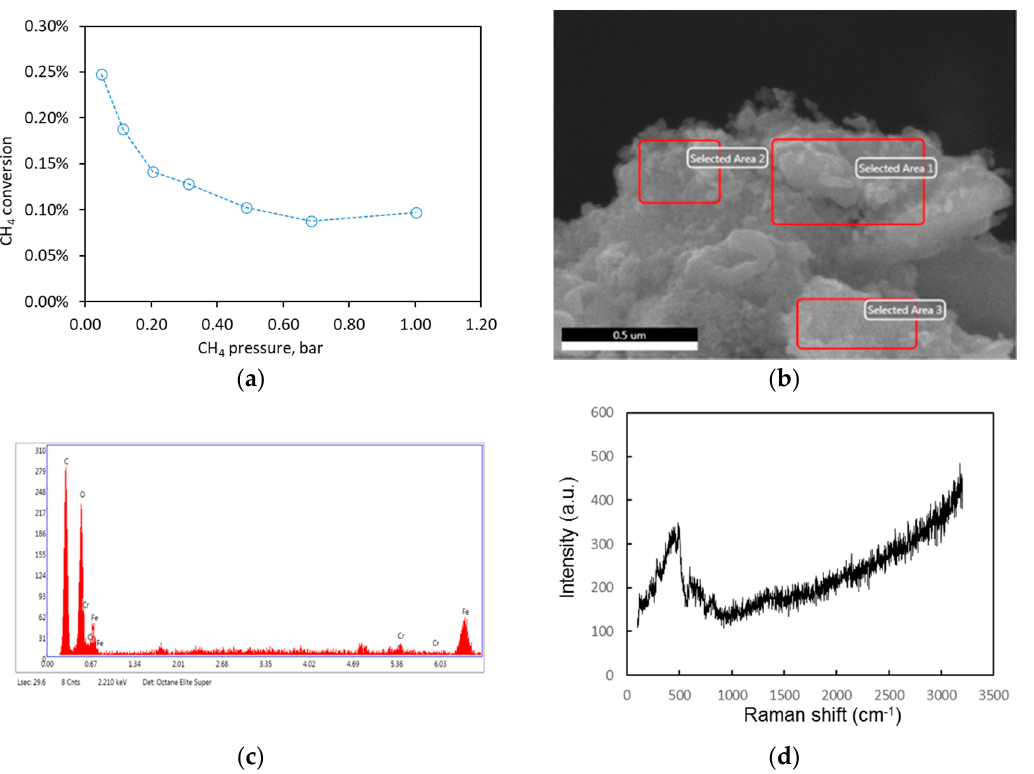
Figure 5. Results of pure CH 4 reaction on the FrCr catalyst: ( a ) CH 4 conversion as a function of feed CH 4 partial pressure, ( b ) SEM of the solid products, ( c ) the EDS elemental survey, and ( d ) the Raman shift spectrum for the carbon products.